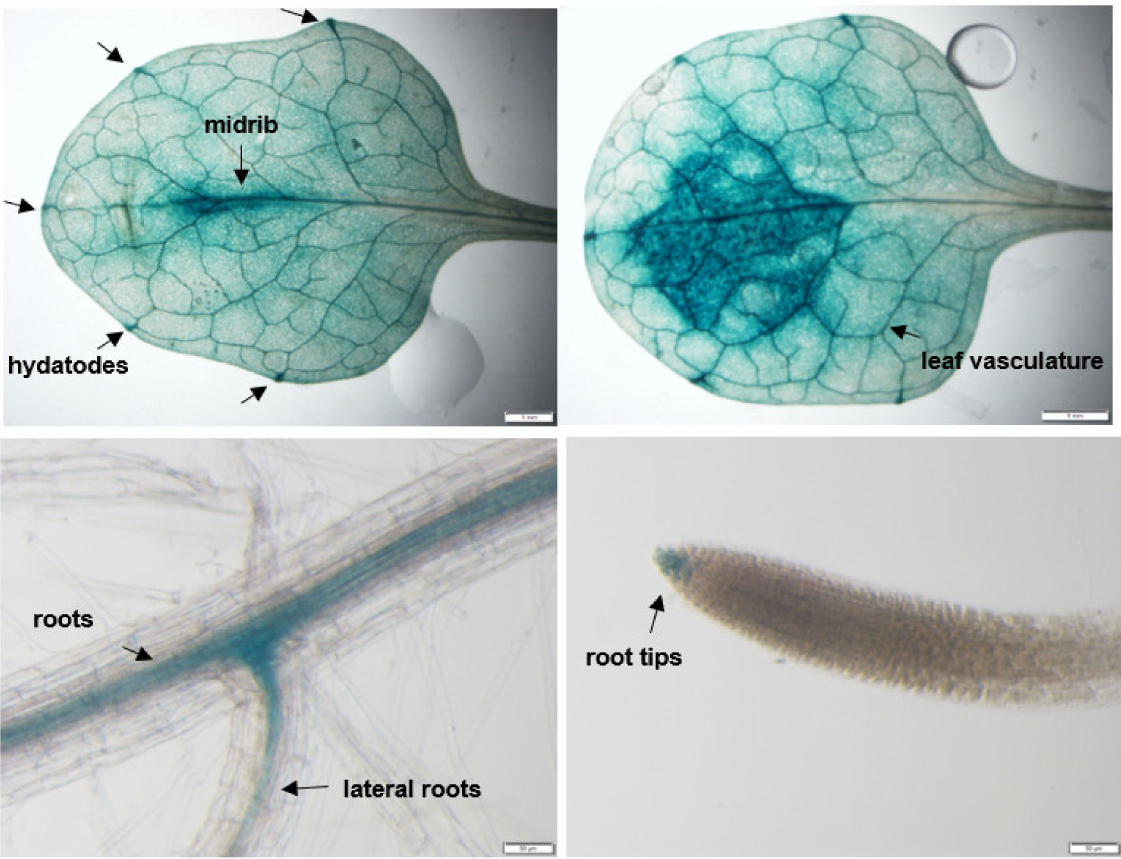
Figure 4. Spatial expression pattern of AtMFDX1 in Arabidopsis. Histochemical staining of different organs (arrows) of transgenic Arabidopsis seedlings expressing pMFDX1 : GUS . One-month-old pMFDX1 : GUS -expressing Arabidopsis plants were stained with X-Gluc. Photographs of leaf vasculature, roots, lateral roots, root tips and hydatodes were taken 24 h after staining using a stereo microscope. A pronounced accumulation of GUS signal can be observed around the leaf midrib. Scale bars = 50 µ m for roots and 1 mm for